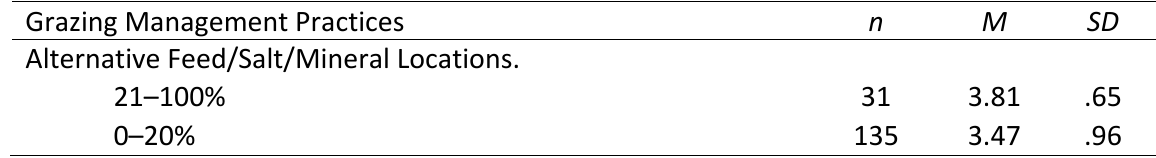
Descriptive Statistics of Income on Intention to Adopt Grazing Management Practices n M SD Alternative Feed/Salt/Mineral Locations.